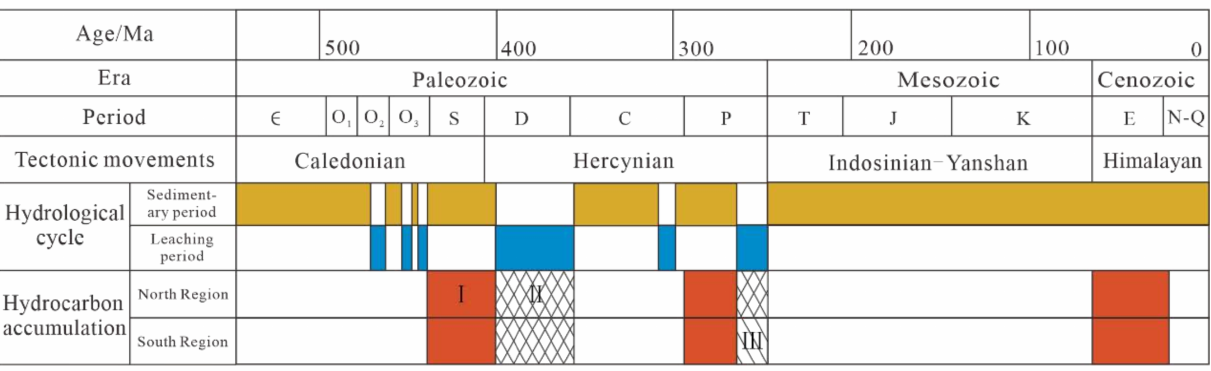
Figure 6. A sketch showing the hydrocarbon accumulation events and factors in the Halahatang depression. I: oil and gas accumulation; II: oil and gas reservoirs destroyed extensively; III: oil and gas reservoirs destroyed slightly. The leaching period mainly developed in the Caledonian and Hercynian periods. Reservoirs formed in the Late Caledonian-Early Hercynian periods were basically destroyed in both North Region and South Region. Reservoirs formed in the Late Hercynian period experienced weaker destruction in South Region than those in North